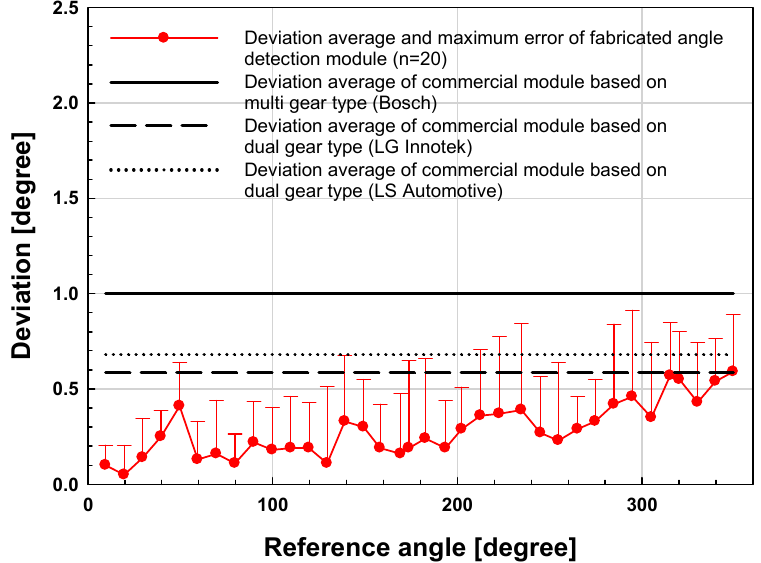
Figure 9. Results and comparison of the proposed angle sensor module and conventional module by test stand experiments versus reference